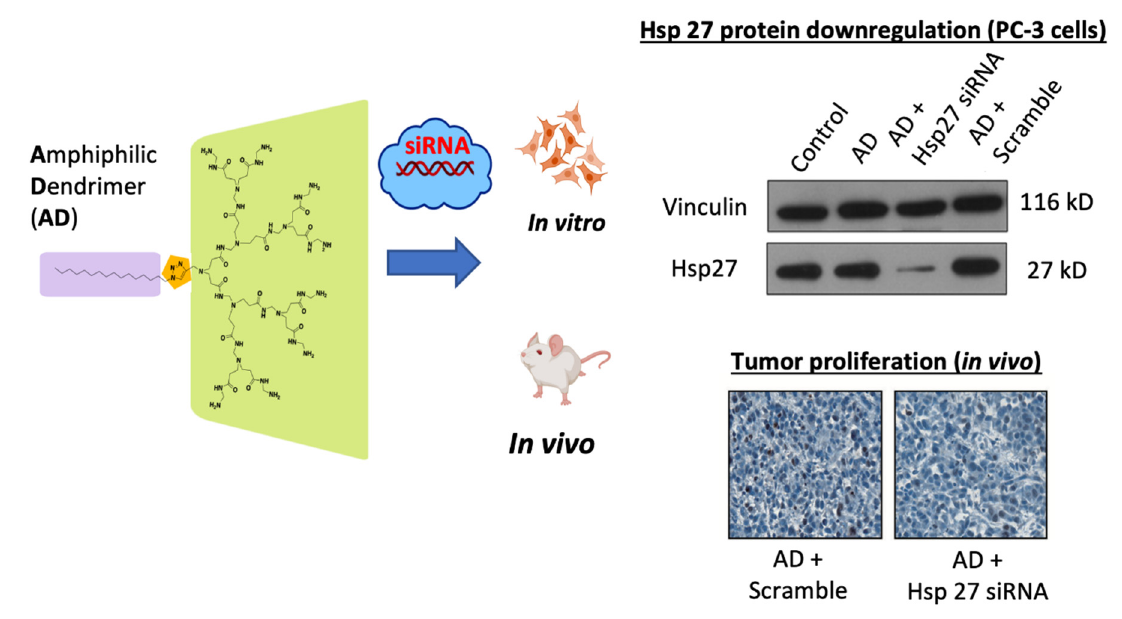
Figure 13. Structure and anti-cancer effect of the AmDM vector used with a siRNA targeting Hsp27. The AmDm vector is an amphiphilic dendrimer (in violet the hydrophobic alkyl chain, in green the dendrimer part of PANAM hydrophilic). Hsp27 protein is significantly under-translated and tumor proliferation reduced with treatment [173], Pharm Res. 2014.